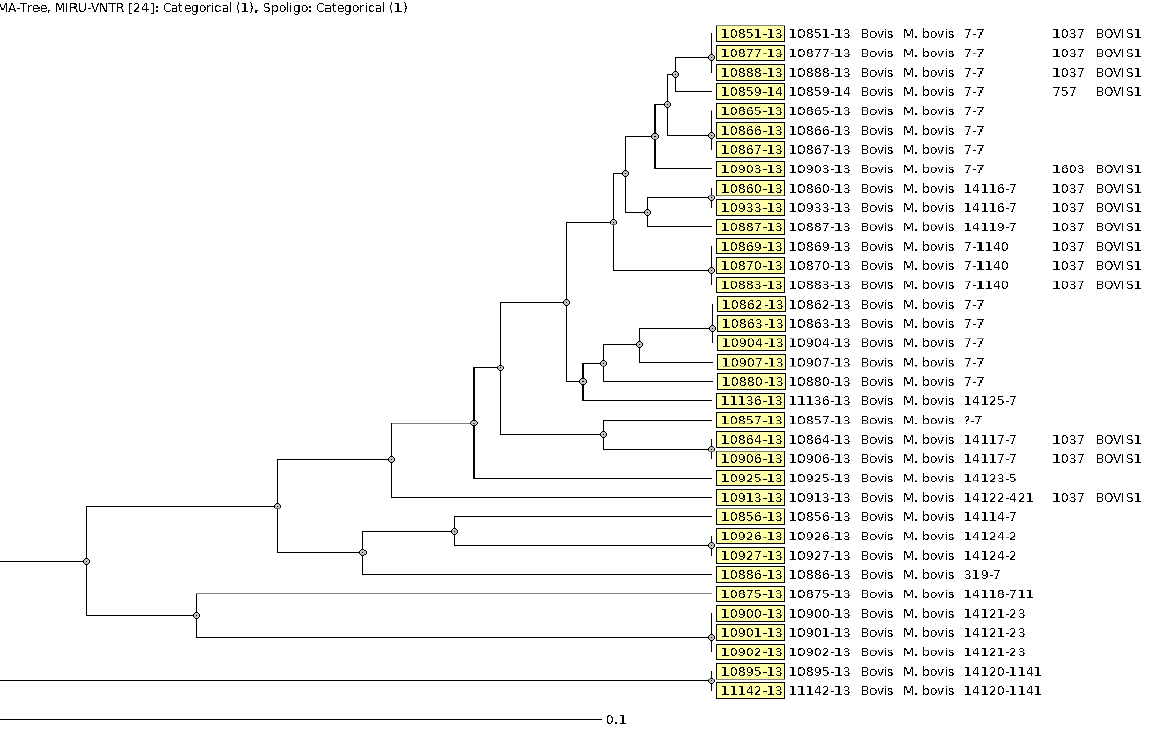
Figure 3. Genetic diversity (i.e., phylogenetic relationship) among M. bovis strains isolated and characterized. Unweighted pair group method with arithmetic mean (UPGMA) tree calculated using 35 strains. Table 4. MLVA 15-9 codes of the M. bovis strains.